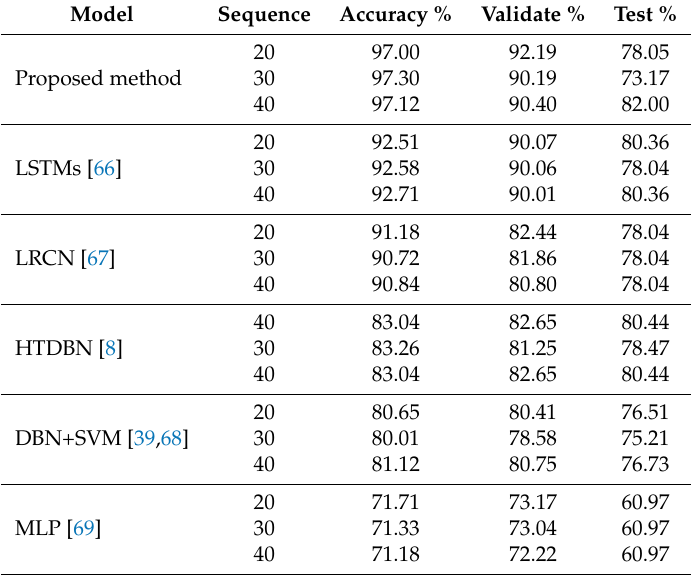
Table 1. Drowsy driving detection on the NTHUDDD